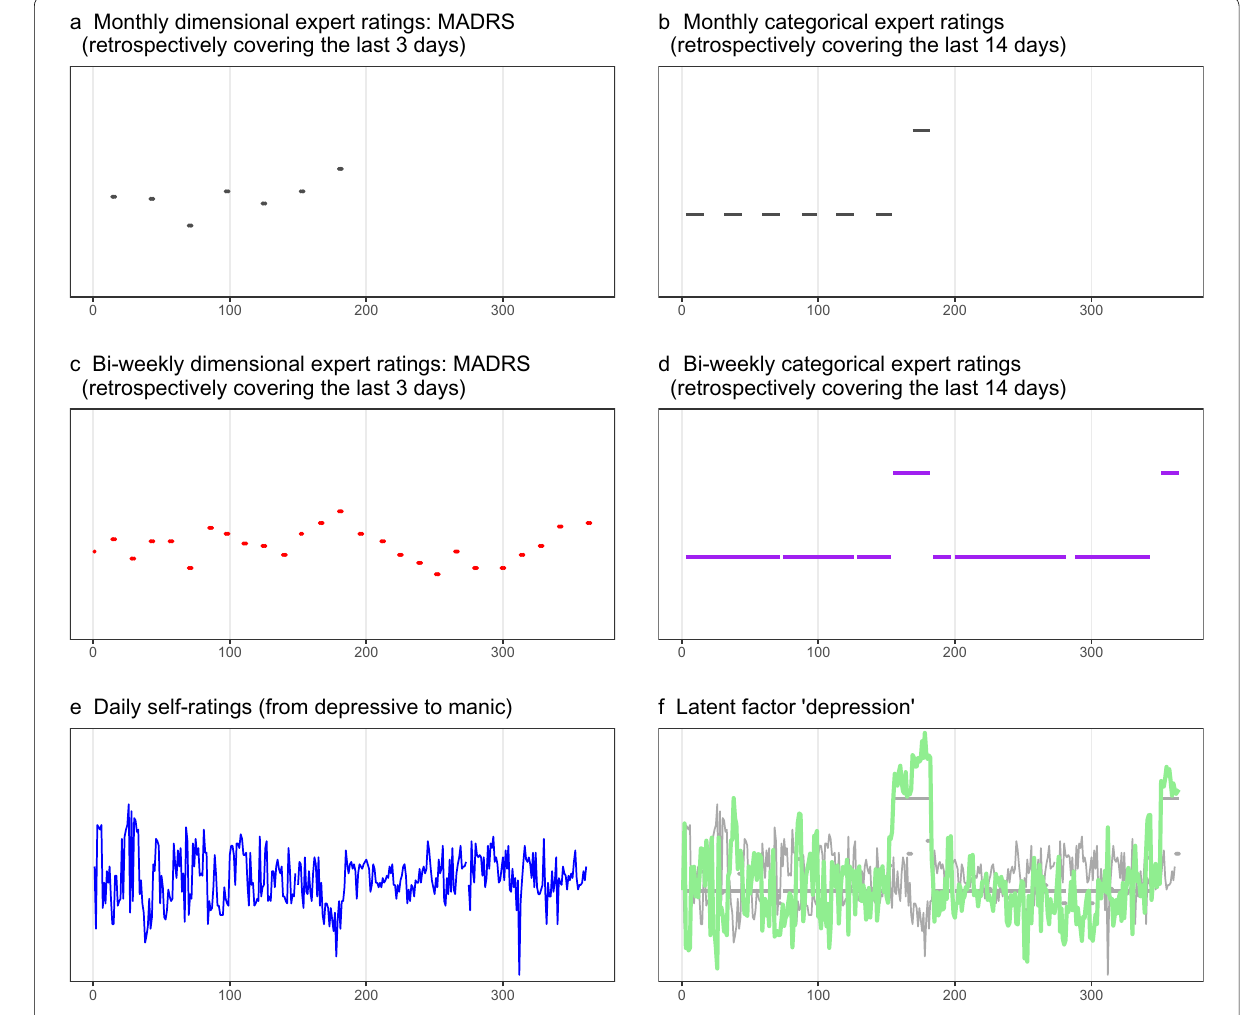
Fig. 1 Outcome data (psychopathological status) from patient ID 4458 simulating common assessment strategies ( a , b ) and illustrating the actual assessment ( c – e ) and the derived latent outcome ( f ). The x‑axis represents days, and the y‑axis represents standardized